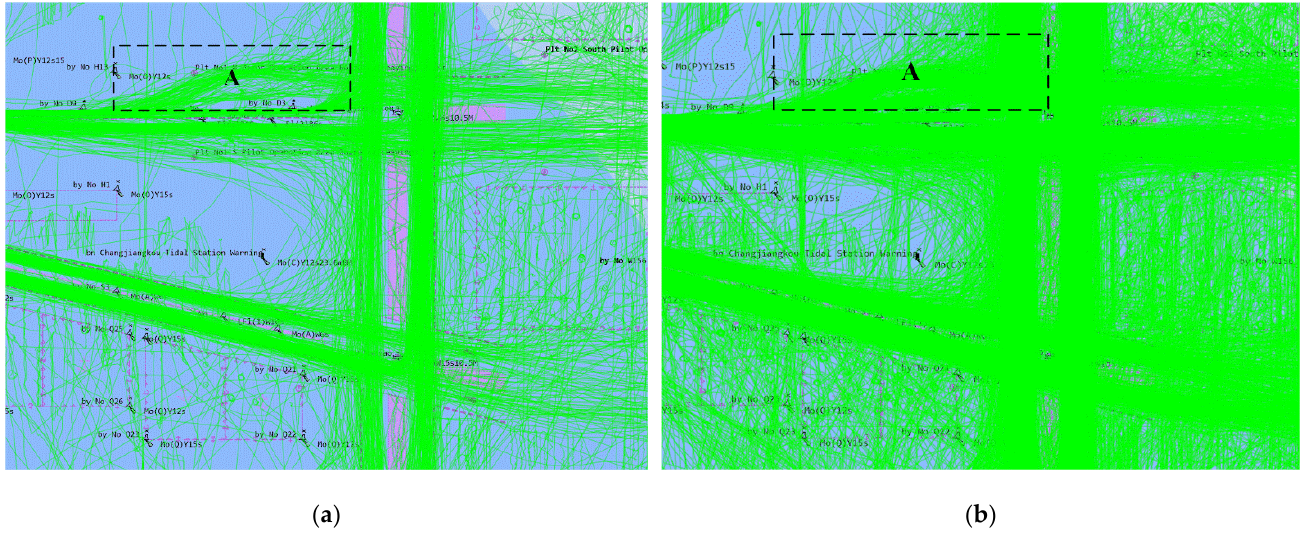
Figure 5. Multi-vessel trajectory display: ( a ) trajectory display from 1 to 3 April; ( b ) trajectory display from 1 to 10